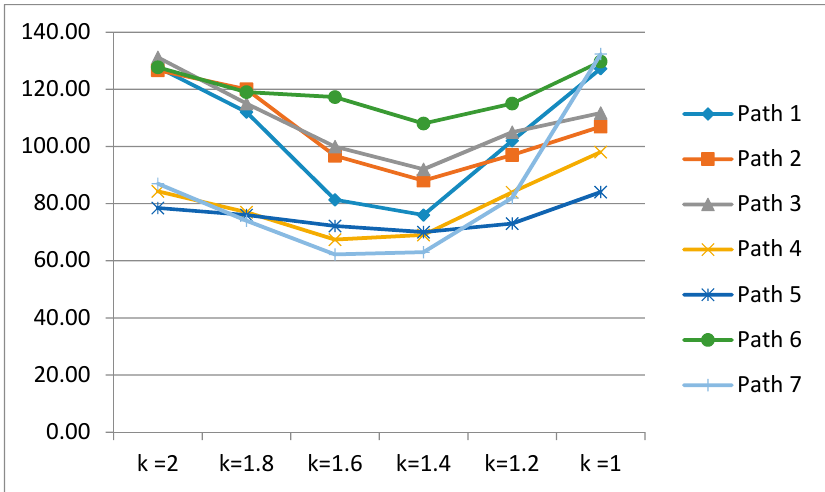
Figure 9. Error charts for k values (unit of y -axis: cm).